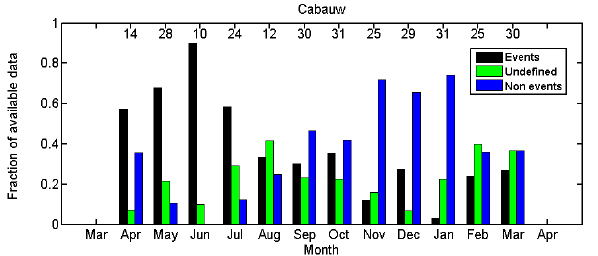
Fig. A7. The fraction of event, undefined and non-event days out of all analyzed days during each month in the year at Hohenpeissenberg, Germany, during April 2008–April 2009.